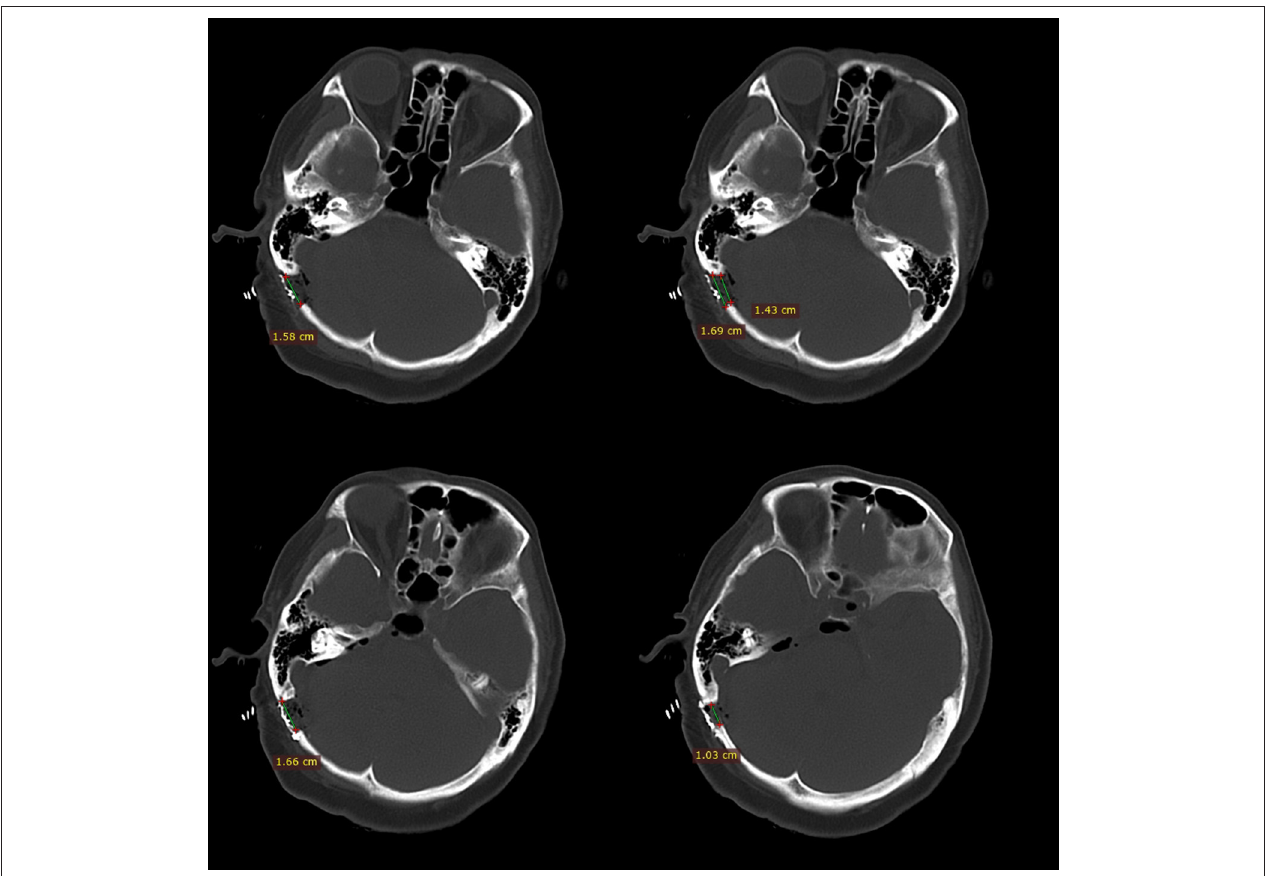
FIGURE 4 | This figure shows the relative positional relationship between the bone window and the mastoid air chamber. Minimally invasive craniotomy (within 2 cm) can avoid opening the developed mastoid air